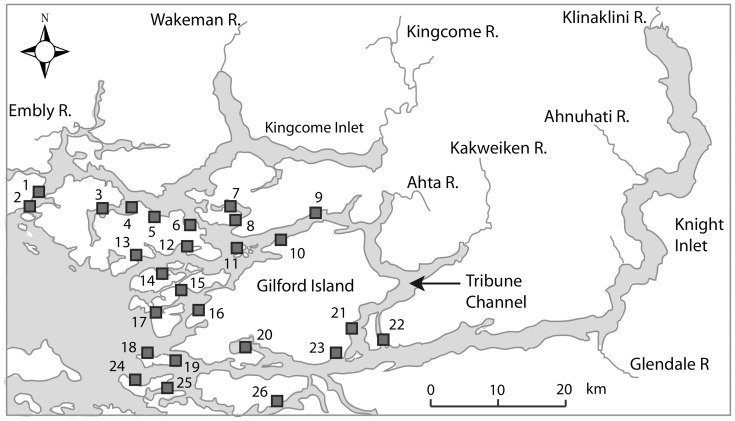
Location of salmon farms in the Broughton Archipelago, BC.Pre-treatment data come from farms 1–4, 6, 8, 9, 11, 13, 15, 17, 18, 20–26. Post-treatment data come from farms 1–4, 6, 9, 11, 13, 17–24. Average temperature and salinity (Table 3) correspond to data from farms 1–9, 11–26.